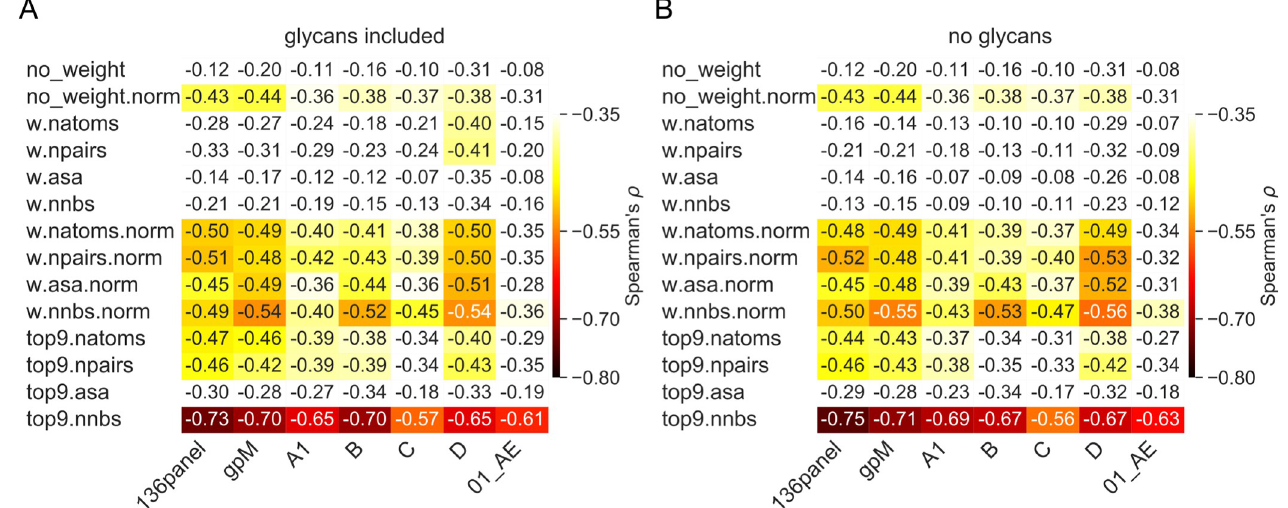
Fig 3. Relationship between neutralization breadth and Env epitope diversity. Epitope diversity measures were calculated using different Env dataset (columns) and different weighting schemes (rows). Spearman’s ρ coefficients corresponding to the relationship between neutralization breadth and Env epitope diversity are presented with (A) and without glycans (B) included in the calculations and color-coded for ρ values that showed a p-value < 0.05. The Env datasets tested are the panel of 136 viruses experimentally-assayed for neutralization (136panel), the global distribution of HIV-1 (gp M), and five subtype- specific alignments (A1, B, C, D and CRF01_AE). In rows, epitope sites were not weighted (no_weight), or weighted by the number of Ab atoms contacted (w. natom), the number of atom pairs in contact between the epitope and the Ab (w.npairs), the reduced accessible surface area after Ab binding (w.asa) and the number of neighboring Ab residues in the Ab:Env complex (w.nnbs). If only the top nine epitope sites were selected for diversity estimations, a prefix ‘top9’ was applied. Epitope diversity values normalized for the size of the epitope are indicated with the suffix ‘norm’.